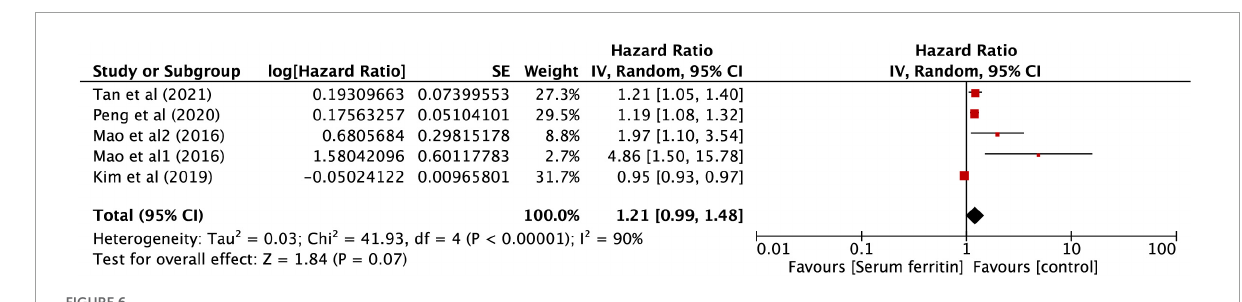
FIGURE6 Forest plots of hazard ratios for the association between expression of SF for KD in five studies.